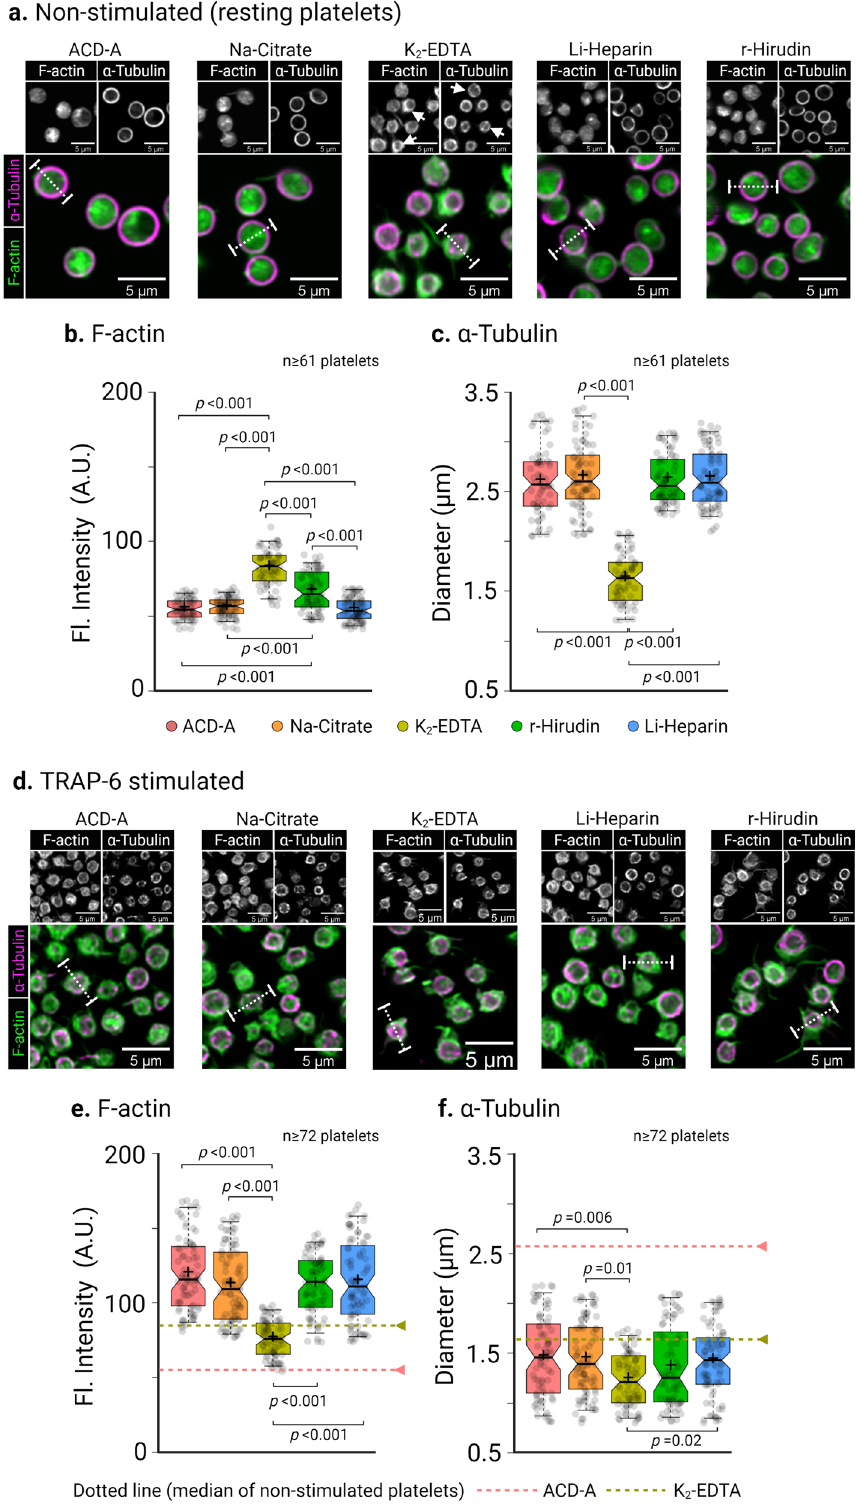
Fig. 4 Cytoskeletal organization in resting and TRAP-6 stimulated human platelets are altered in different ex vivo anticoagulants. Representative confocal laser scanning fl uorescence microscopic images of F-actin (green) distribution and marginal band α -tubulin (magenta) organization of human platelets in different ex vivo anticoagulants in ( a ) non-stimulated (resting platelets) and ( d ) 10min after TRAP-6 stimulation. Line pro fi le fl uorescence intensity distribution analysis of F-actin and edge-to-edge distance of α -tubulin ( b ) and ( c ) in non-stimulated platelets and after TRAP-6 stimulation ( e ) and ( f ). Dotted horizontal lines in ( e ) and ( f ) correspond to the median fl uorescence intensity and diameter of respective parameters from non-stimulated platelets. Notch in the box plot and the plus sign depicts median and mean, respectively, and the interquartile ranges. Staggered dots in gray show the distribution of data points. Statistical assessment by Kruskal-Wallis-Test followed by Dunn ’ s multiple comparisons test p < 0.05 was considered signi fi